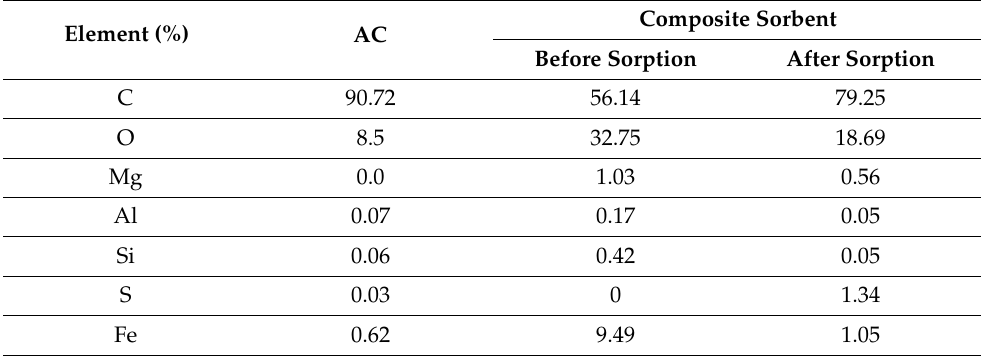
Table 2. Percentages of elements in the AC and composite sorbent before and after sorption of SO 42 − ions specified by EDS